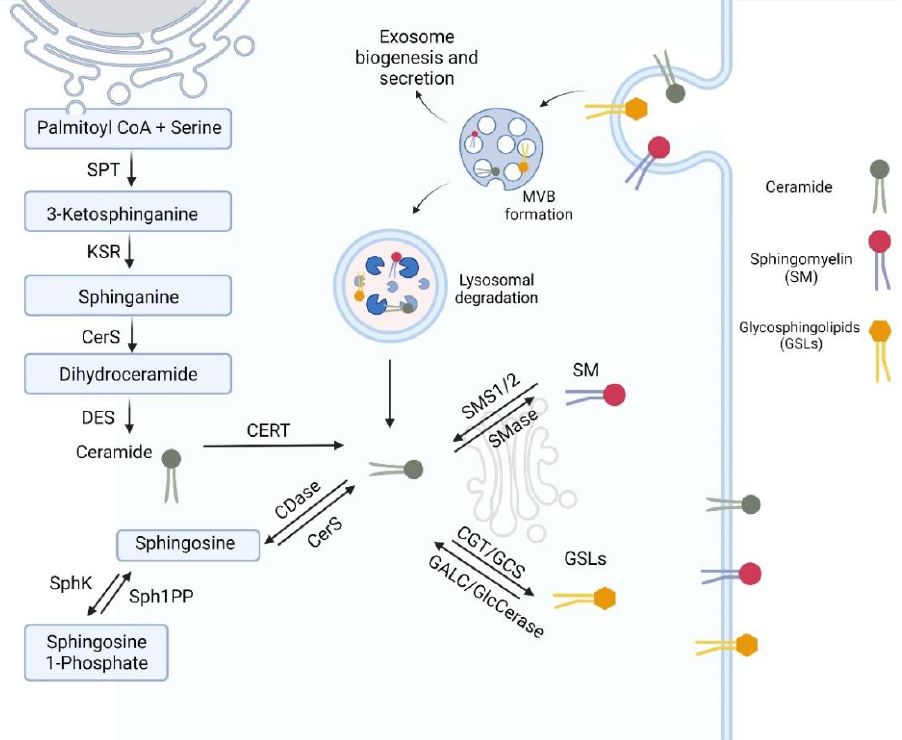
Figure 2. Sphingolipid (SL) metabolism showing de novo ceramide synthesis at the endoplasmic reticulum. It is then transferred to the Golgi apparatus where it can be modified to complex SLs and subsequently transported to the plasma membrane. There is recycling of SLs through the endosome, then multivesicular body (MVB) formation and finally lysosomal degradation. Ceramide can be fur- ther broken down into sphingosine and spingosine-1-phosphate. SPT — serine palmitoyl transferase, KSR — 3-Ketosphinganine reductase, CerS — ceramide synthase, DES — dihydroceramide desaturase,